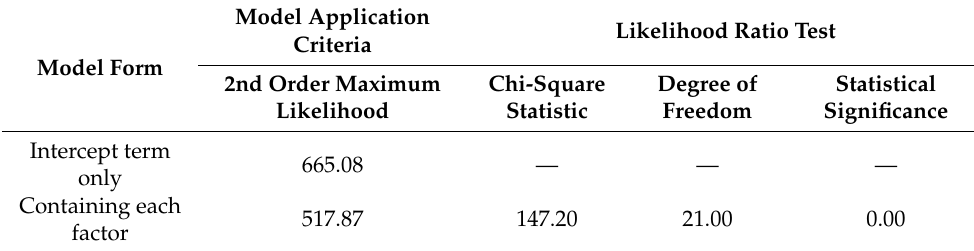
Table 4. Maximum likelihood ratio test results of the model.